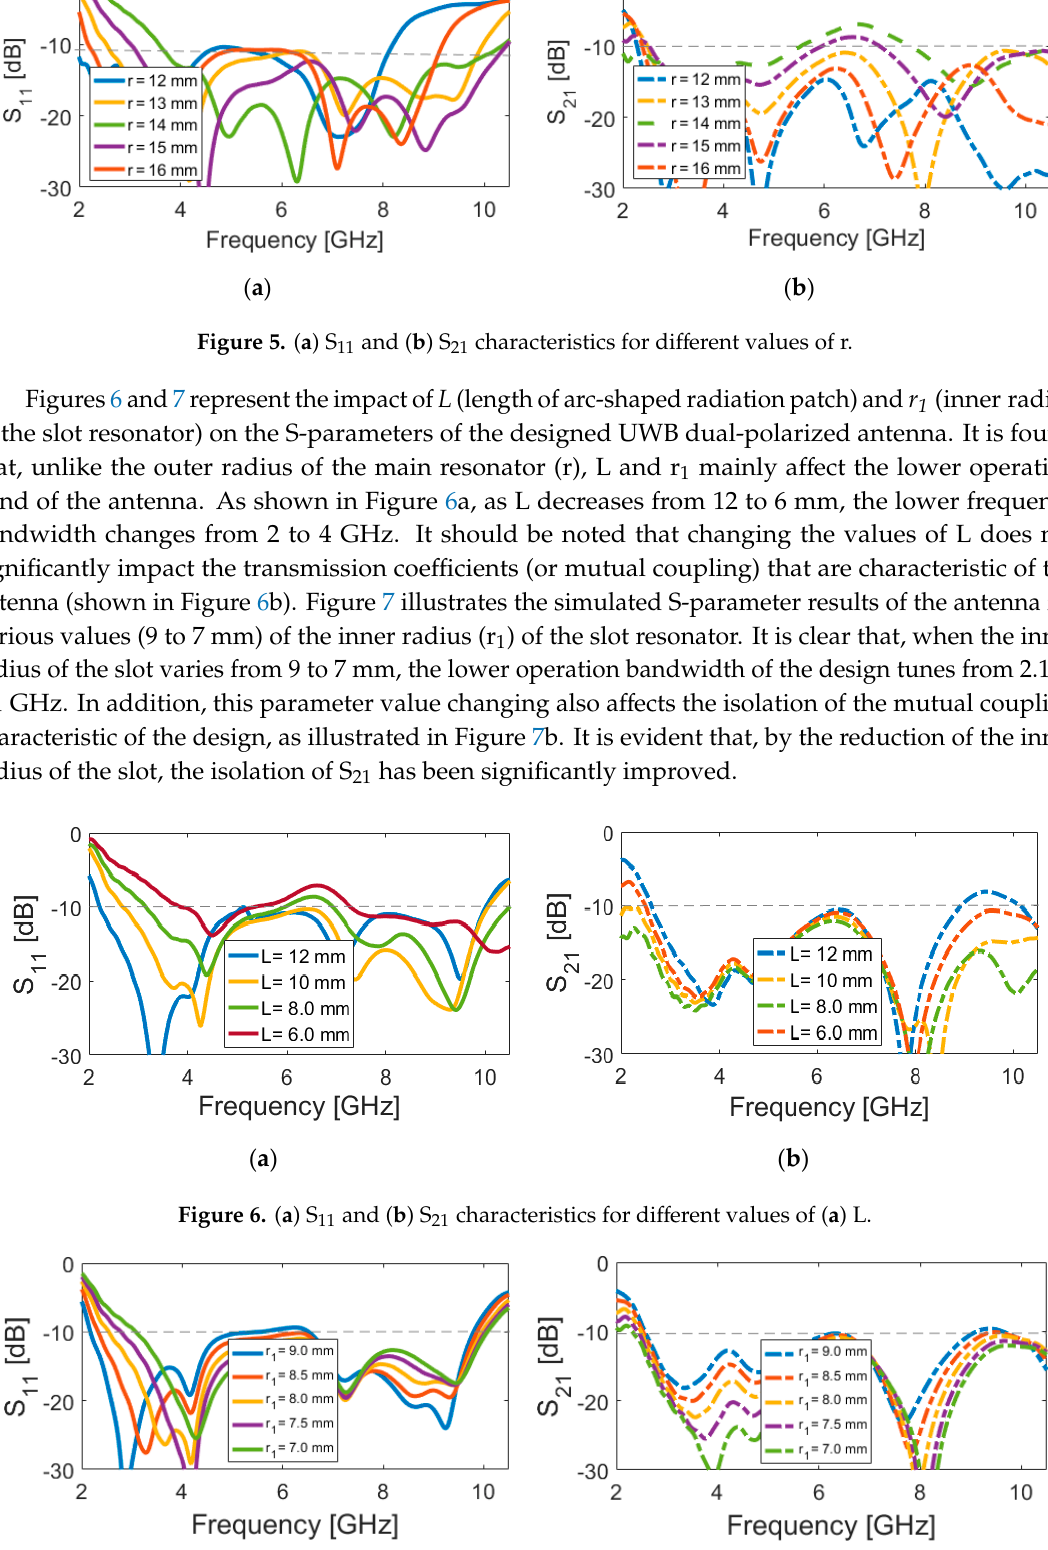
Figure 6. ( a ) S 11 and ( b ) S 21 characteristics for different values of ( a ) L.